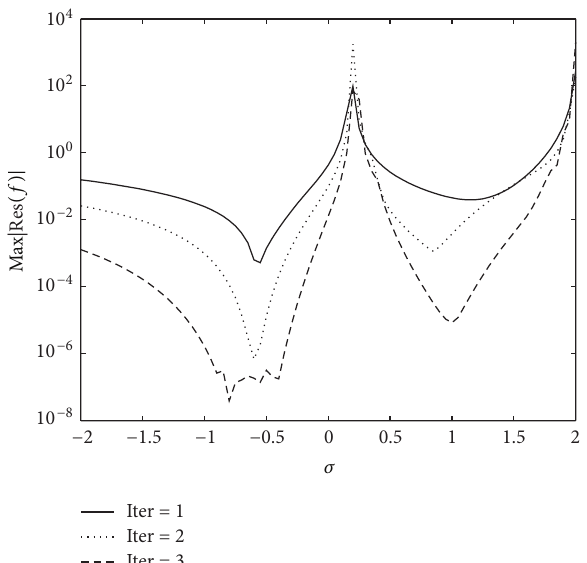
Figure 4: Maximum residual curve for varying 𝜎 when 𝜆 = 𝑠 = 𝐴 = 1